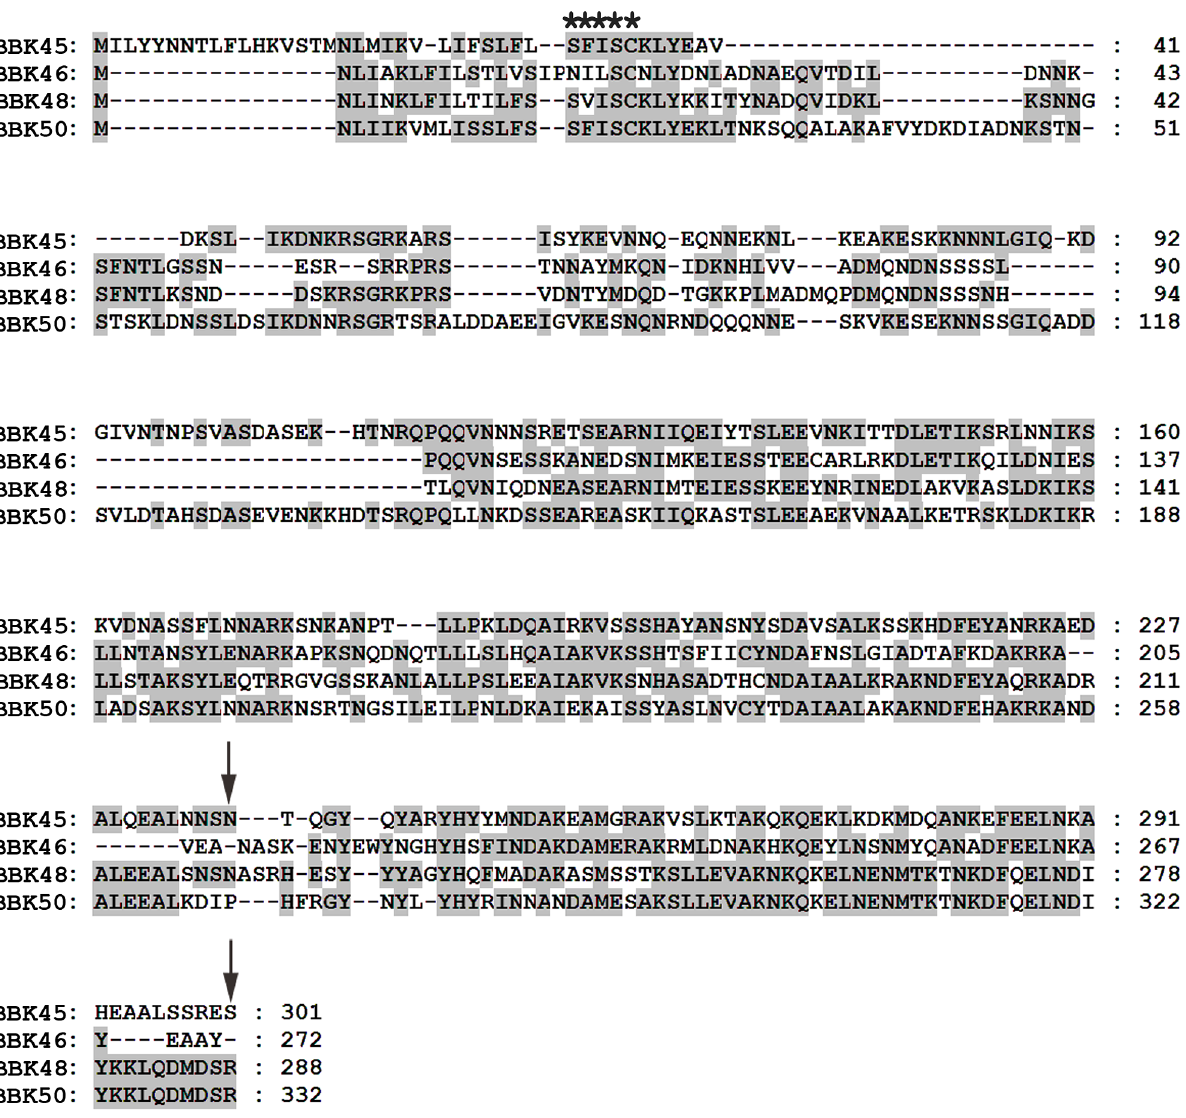
Figure 4. Amino acid alignment of the putative members of the immunogenic protein P37 family encoded on lp36. Shown is an amino acid alignment of the P37 protein family members BBK45 (GenBank accession no. NP_045617.2), BBK46 (translated bbk46 , Genbank GeneID: 1194234), BBK48 (GenBank accession no. NP_045619.1) and BBK50 (GenBank accession no. NP_045621.1). Amino acids identical to the consensus sequence are shaded. The predicted SpLip lipobox sequence [81] is indicted with five stars. Dashes represent spaces introduced for optimal sequence alignment. The positions of the two stop codons in the bbk46 translation are indicated with arrows. Amino acid sequences were aligned using the CLUSTAL W algorithm in the MEGALIGN program from the DNASTAR Lasergene